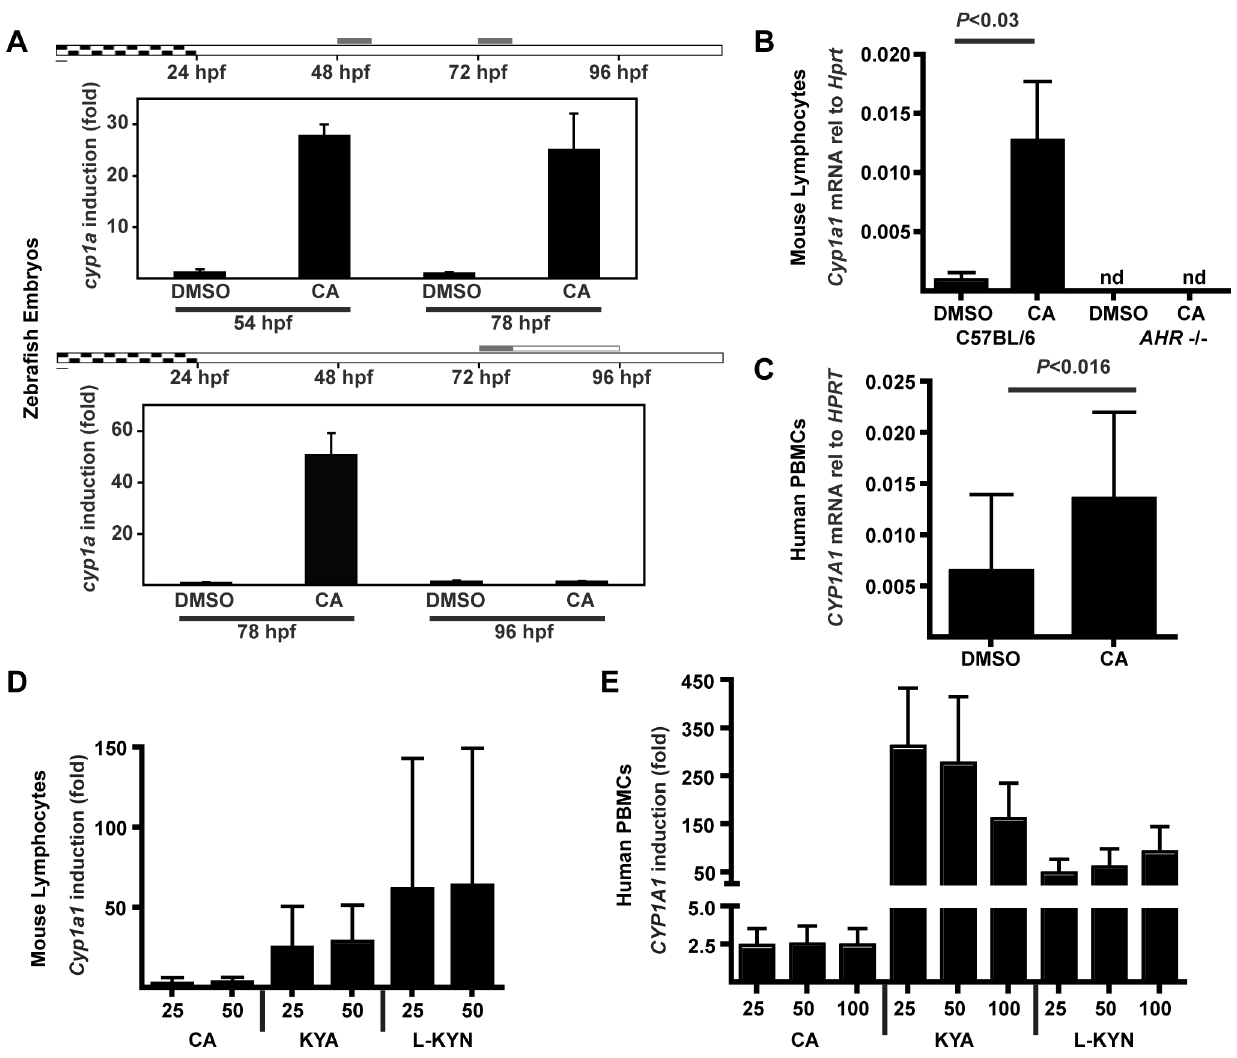
Figure 7. CA induces expression of AHR-responsive gene Cyp1a1 , but with reduced efficacy versus other tryptophan metabolites. (A) Induction of cyp1a in vivo as measured by qRT-PCR. Zebrafish embryos at 48 or 72 hours post fertilization (hpf) were exposed to CA (100 m M) for 6 hours, and either sampled immediately (54 or 78 hpf; top panel) or placed in clean water and sampled at 96 hpf (24 hours after beginning of exposure; bottom panel). Cyp1a mRNA was normalized to beta-actin and to the average DMSO value. (DMSO values for 78 and 96-hpf embryos were similar). Values represent fold-change in CA-treated versus DMSO control embryos; each panel represents an experiment sampling three replicate groups of twenty embryos per group. (B) Induction of Cyp1a1 in wild-type ( Ahr + / + ) or Ahr 2 / 2 mouse total lymphocytes incubated with CA (50 m M) in RPMI for 4 hours. Cyp1a1 was measured by qRT-PCR and normalized to Hprt . Error bars represent SD. P values were calculated with the Mann- Whitney test from lymphocyte cultures from three individual mice. (C) Induction of CYP1A1 PHA-stimulated human total PBMCs after 12–20 hours of incubation with CA (50 m M) in RPMI. CYP1A1 was measured by qRT-PCR and normalized to HPRT . Data shown are pooled experiments from six individual donors. Error bars are SD. P values were calculated with the Mann-Whitney test. (D, E) Induction of mouse Cyp1a1 (D) and human CYP1A1 (E) measured by qRT-PCR relative to Hprt or HPRT . Mouse lymphocytes (D) and PHA-stimulated human PBMCs (E) were incubated with CA, KYA, L- KYN. Values are pooled from at least three independent experiments and represent fold-change versus averaged DMSO control. Metabolite concentrations are in m M. Error bars represent SD.